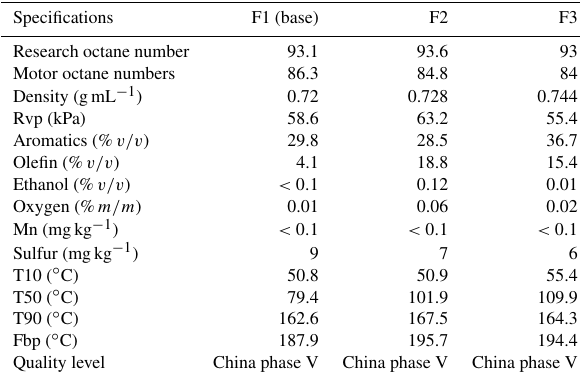
Table 1. Parameters of the tested